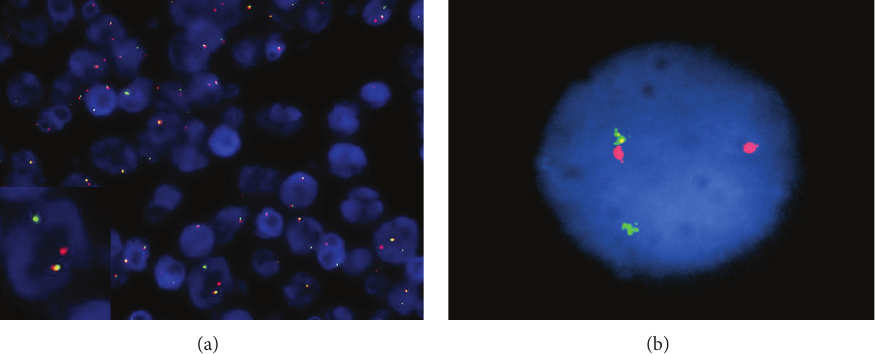
Figure 4: FISH analysis using ALK dual colour break-apart rearrangement probe showing breakage of the one allele of the ALK gene locus in many of the nuclei examined in left axillary lymph node biopsy, inset showing enlarged nucleus (original magnification × 200) (a) and the same findings in the peripheral blood (original magnification × 1000)